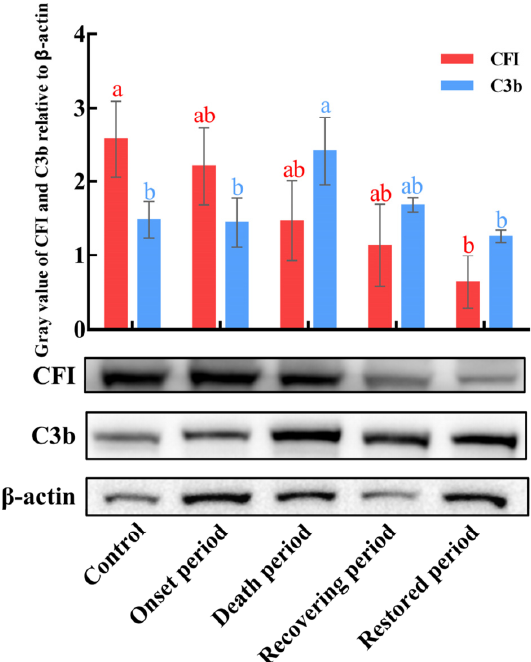
Figure 9. The protein content changes of CiCFI and CiC3b in the serum of grass carps after GCRV infection. Letters a and b indicate significant differences among the expressions in the serum at var- ious periods post-GCRV infection ( p < 0.05). various periods post-GCRV infection ( p <